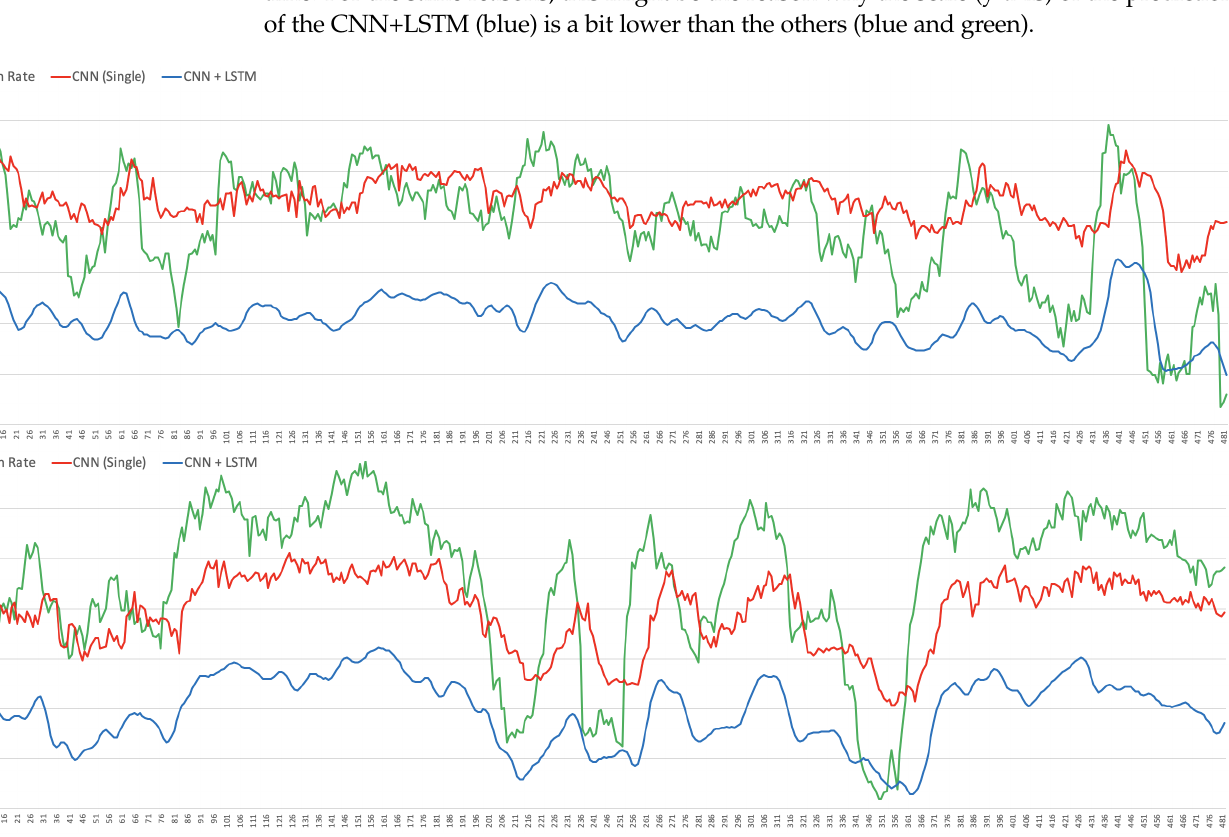
Figure 10. Illustrative comparisons of the brain rate index, the single Convolutional Neural Network (CNN) predictions and the Convolutional/Recurrent Neural Network (CNN+LSTM) predictions for two random participants and a random video used in the test